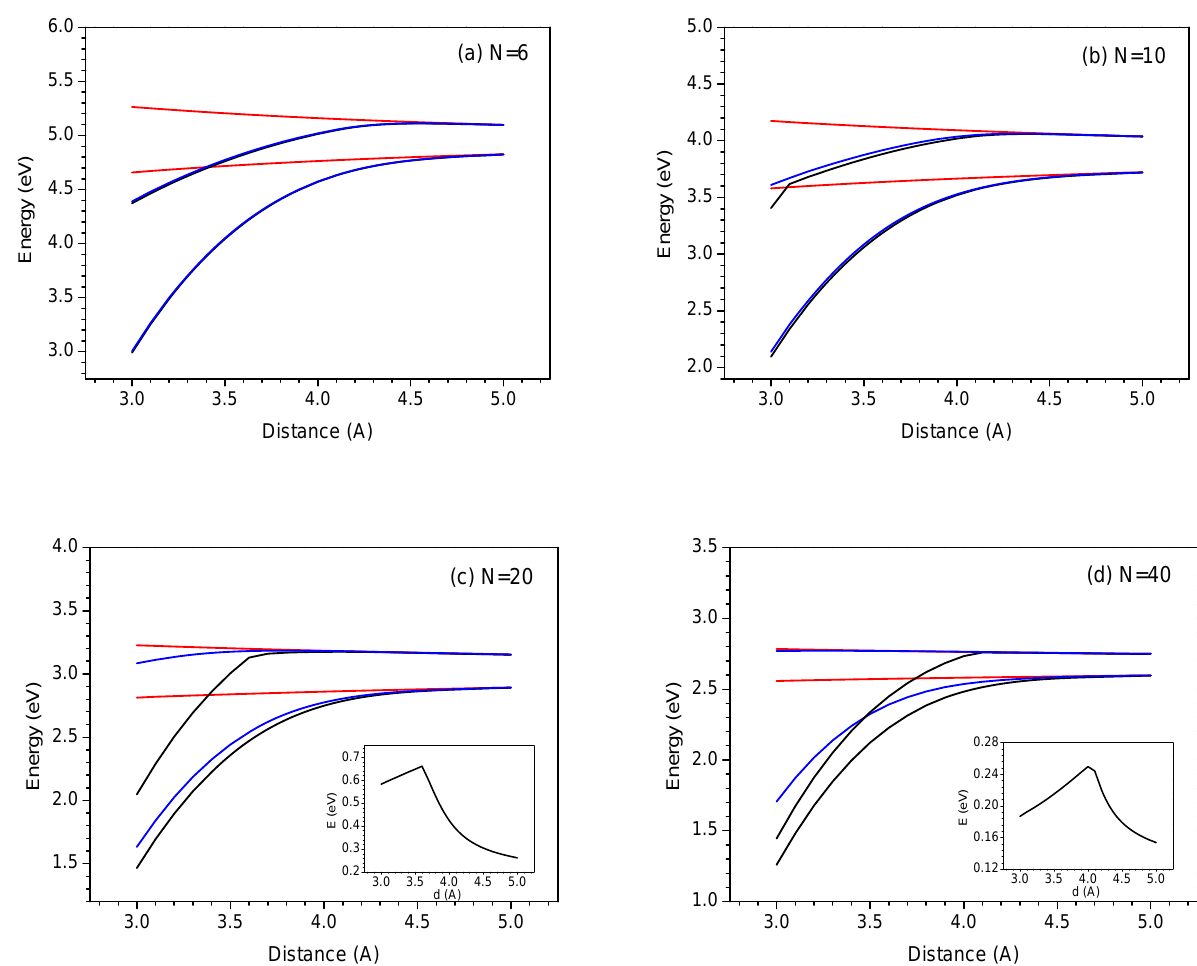
Figure 2. Distance dependence of the two low-lying excited states of various polyene dimers, with N = 6 (a) , 10 (b) , 20 (c) , 40 (d) calculated by model 1 (black), model 2 (blue) and model 3 (red line). The insets show the evolution of the energy gap of the two transitions as a function of the intermolecular distance (calculated by model 1). For clarity the data calculated by model 3, we specify the exact values at 3.0 and 5.0 Å for N = 6 :4.657 eV, 4.827 eV; S :5.264 eV, 5.098 eV), 10 (S :3.580 eV, 3.722 eV; S :4.174 eV, (S 1 2 1 2 :2.814 eV, 2.893 eV; S :3.227 eV, 3.153 eV), 40 (S :2.558 eV, 2.596 eV; 4.037 eV), 20 (S 1 2 1 eV) [46]. Reproduced with permission from American Chemical